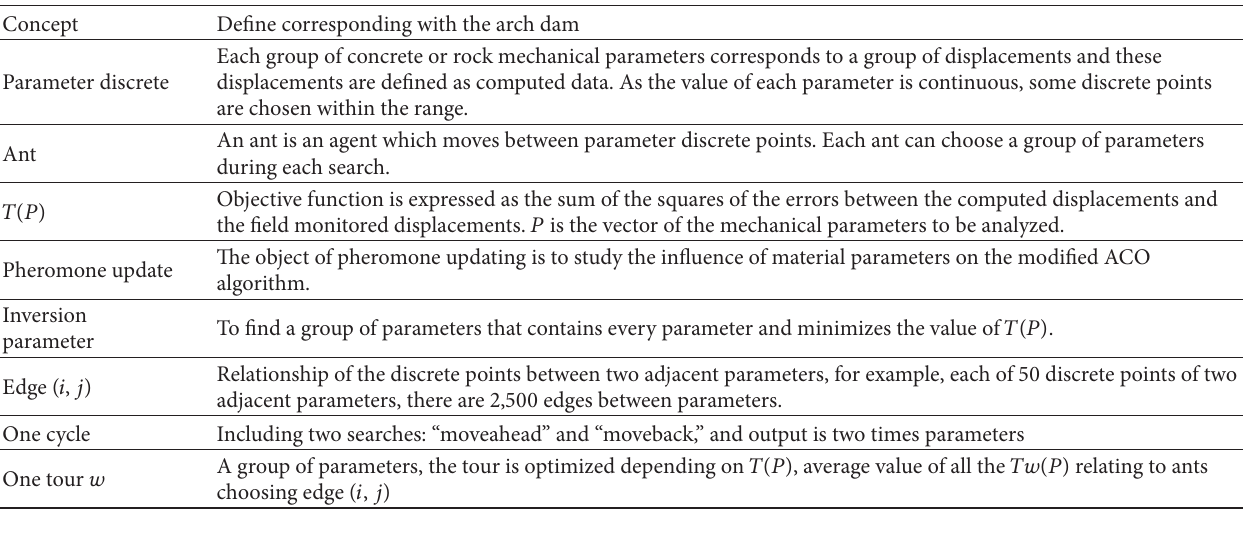
Table 1: The key concept and parameters of the ACO model corresponding with the arch dam.